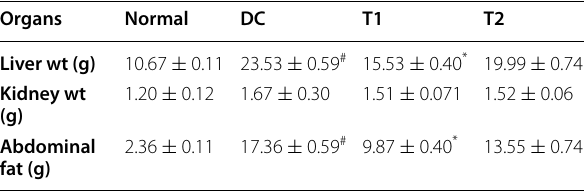
Values are expressed as mean SD ( n 6). # Significantly ( p < 0.05) different from ± = Normal Control. * Significantly ( P < 0.05) different from Disease Control. Statistical analysis was performed by applying one-way ANOVA followed by Dunnet’s Test using Graph Pad Prism V6.0. Statistical significance was kept at P < 0.05 NC Normal control, DC Disease control, T1 Probiotic fermented milk with WPC and SPI, T2 Probiotic fermented milk without WPC and SPI